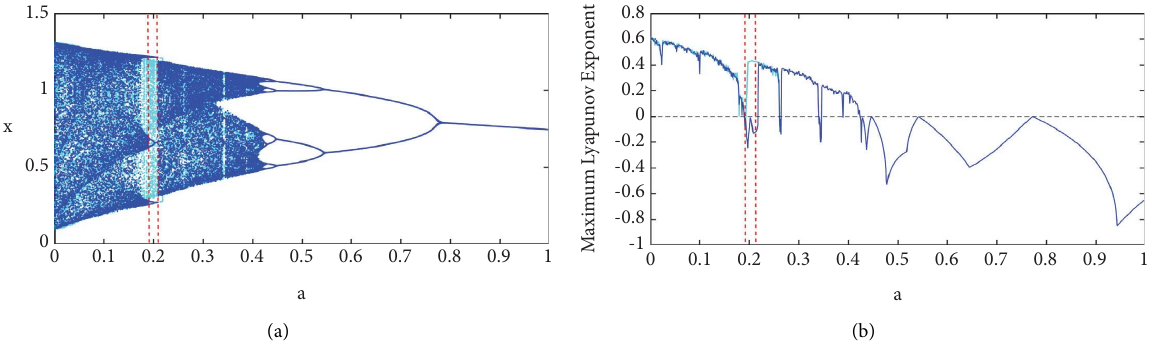
Figure 12: Coexisting dynamics with respect to the parameter a covering [0,1] with initial conditions (0.08, 0.08) (cyan) and initial conditions (0.7, 0.7) (blue). (a) Bifurcation diagram of the model (4) in ( a, x ) plane. (b) Maximum Lyapunov exponents corresponding to